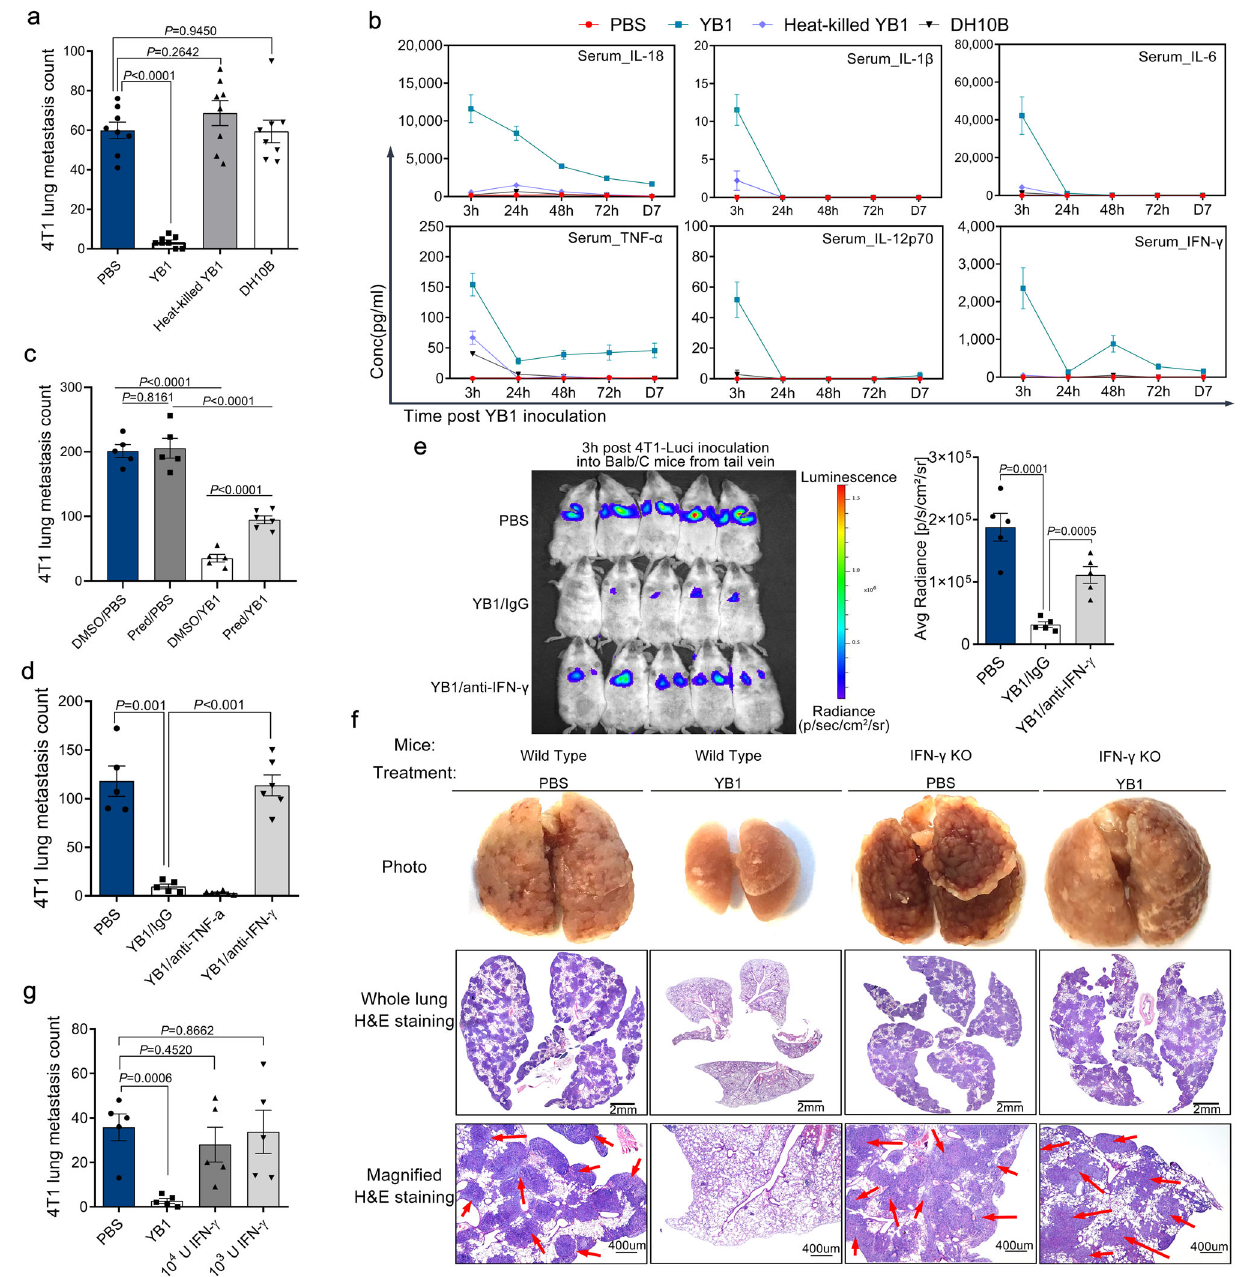
Fig. 3 IFN- γ -dependent in fl ammation induced by Salmonella YB1 infection facilitates the suppression of cancer metastasis. a Quanti fi cation (two-tailed unpaired t -tests, n = 8 per group) of 4T1 lung metastases in mice treated with PBS, YB1, heat-killed YB1, and E. coli DH10B, respectively, on day 0. 4T1 cancer cells were intravenously inoculated on day 13 and lung metastasis was quanti fi ed on day 27. Kinetics of cytokine levels in the serum of these BALB/c mice were monitored ( n = 4 per group) ( b ). Conc, concentration. c Quanti fi cation (two-tailed unpaired t -tests) of 4T1 lung metastases after YB1-induced in fl ammation was inhibited by prednisolone in the 4T1-BALB/c experimental metastasis model ( n = 6 Pred/YB1, n = 5 others). Pred, prednisolone. d Quanti fi cation (two-tailed unpaired t -tests) of 4T1 lung metastases following antibody-mediated depletion of TNF- α and IFN- γ in the 4T1-BALB/c experimental metastasis model ( n = 5 for PBS and YB1/IgG; n = 6 for YB1/anti-TNF- α and YB1/anti-IFN- γ ). e Tracking and quanti fi cation (two-tailed unpaired t -tests) of 4T1-Luci cells in vivo by luciferase live imaging 3 h after i.v. injection of 4T1-Luci into BALB/c mice pretreated with PBS, YB1 plus isotype IgG, or YB1 plus IFN- γ depletion antibody, respectively. BALB/c mice were pretreated 3 days in advance with PBS or YB1 ( n = 5 per group). f Comparison of the anti-metastatic activity of YB1 in wild-type C57BL/6J mice and IFN- γ -knockout (IFN- γ KO) mice based on the experimental metastasis model established with MB49 cancer cells ( n = 5 mice per group). Representative lung pictures, H&E-stained whole lung, and magni fi ed H&E-stained lung tissue from each group were shown. Red arrows indicate partial tumor tissues. Plenty of MB49 tumor nodules were found in lungs from IFN- γ -knockout mice treated either with PBS or YB1 and wild-type mice treated with PBS. g Quanti fi cation of 4T1 lung metastases (two-tailed unpaired t -tests) after treatment with recombinant IFN- γ compared to YB1 or PBS treatment. This experiment was based on the 4T1-BALB/c experimental metastasis model ( n = 5 per group). All data are presented as mean values ± SEM. All displayed are one representative experiment of two independent experiments. Source data are provided as a Source Data fi